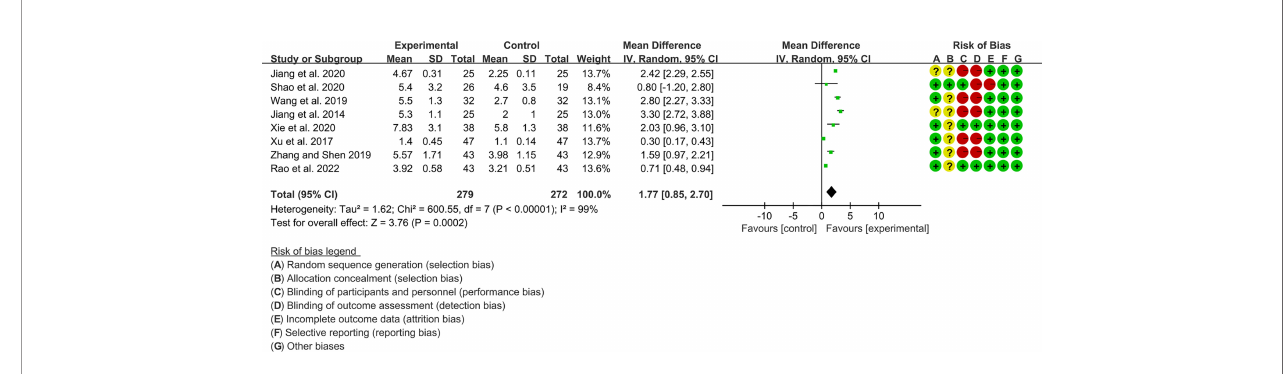
FIGURE 6 | Schirmer ’ s test.